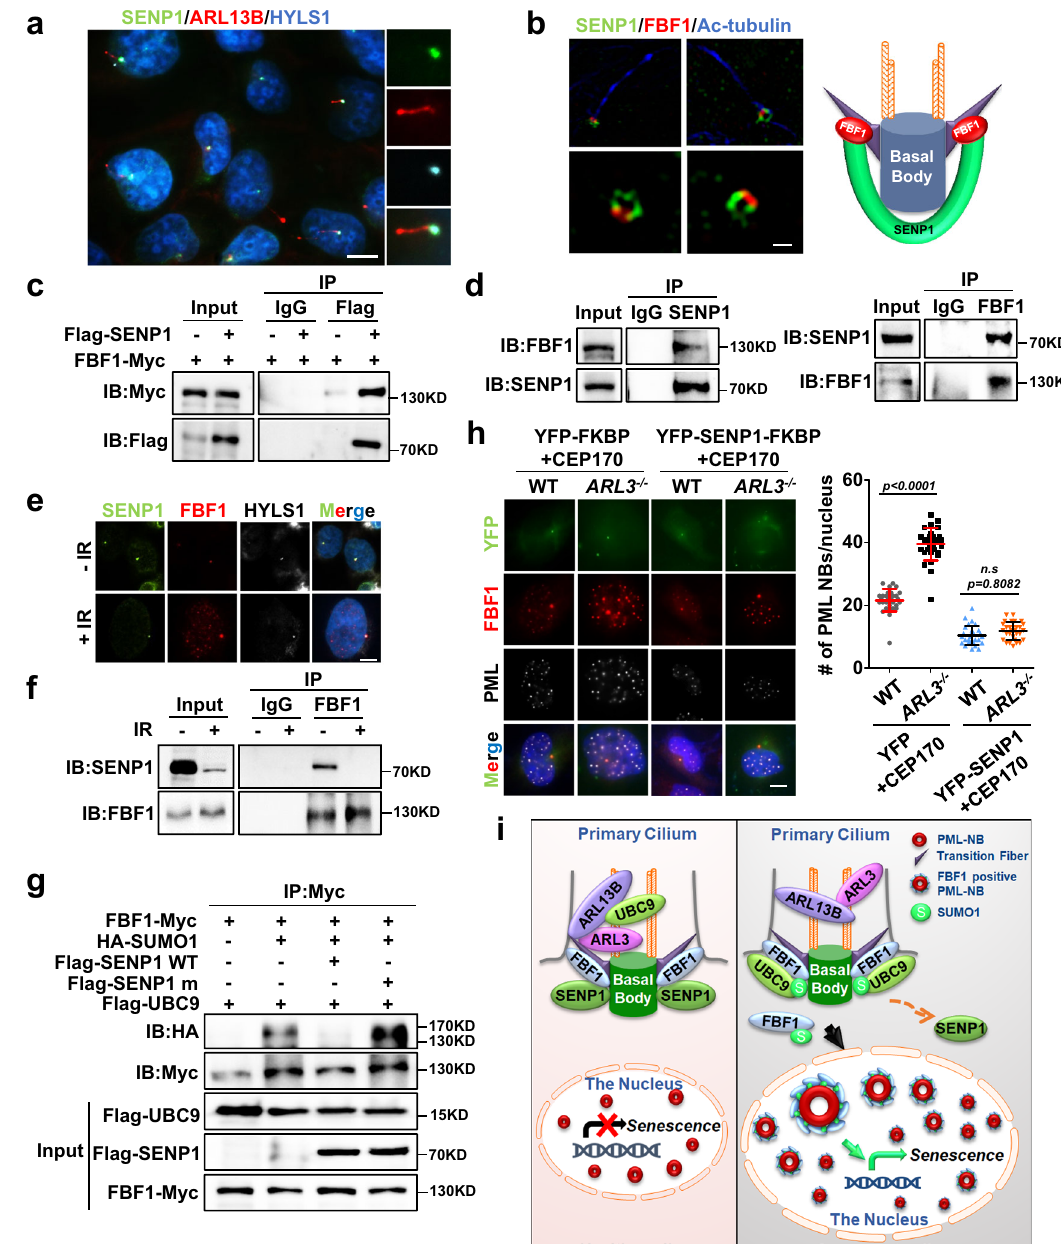
Fig. 5 | DNA damage abolishes the ciliary SUMO protease SENP1 and enhances FBF1SUMOylation.a Immuno fl uorescentimagesforSENP1staining inRCTEcells. Basal bodies were labeled with HYLS1. Scale bar, 10 μ m. b Structured illumination microscopicimagesstainedforFBF1andSENP1atciliarybaseinIMR-90cells.Scale bar, 1 μ m. c Co-immunoprecipitation of SENP1 and FBF1 in 293T cells. d EndogenousSENP1orFBF1immunoprecipitateswithFBF1orSENP1inRCTEcells. e Immuno fl uorescent images in RCTE cells at day 7 without or with irradiation treatment using antibodies against SENP1 and FBF1.Basalbodieswerelabeledwith HYLS1. Scale bar, 10 μ m. f Endogenous FBF1 immunoprecipitates with SENP1 in RCTE cells with or without irradiation. g SENP1 diminished FBF1 SUMOylation in a